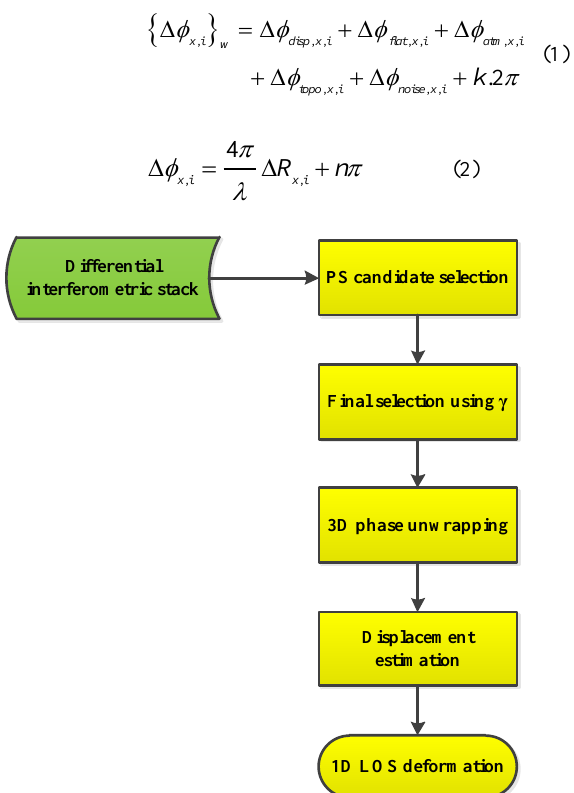
Figure 3. PSI processing chain for Sentinel-1 TOPS differential interferograms.